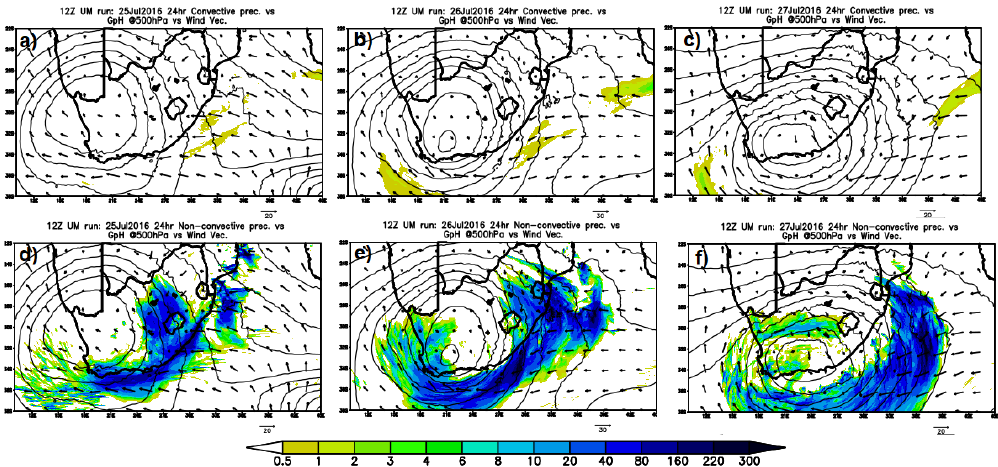
Figure 5. Geopotential heights at 500 hPa (thin contours) together with convection precipitation ( a – c ) at 12Z UM 24 h on the 25th, 26th and 27th July 2016. Bottom panels ( d – f ) are for the same time as in ( a – c ) but for non-convective precipitation. The vectors represent the wind vectors at 10 m above the ground.